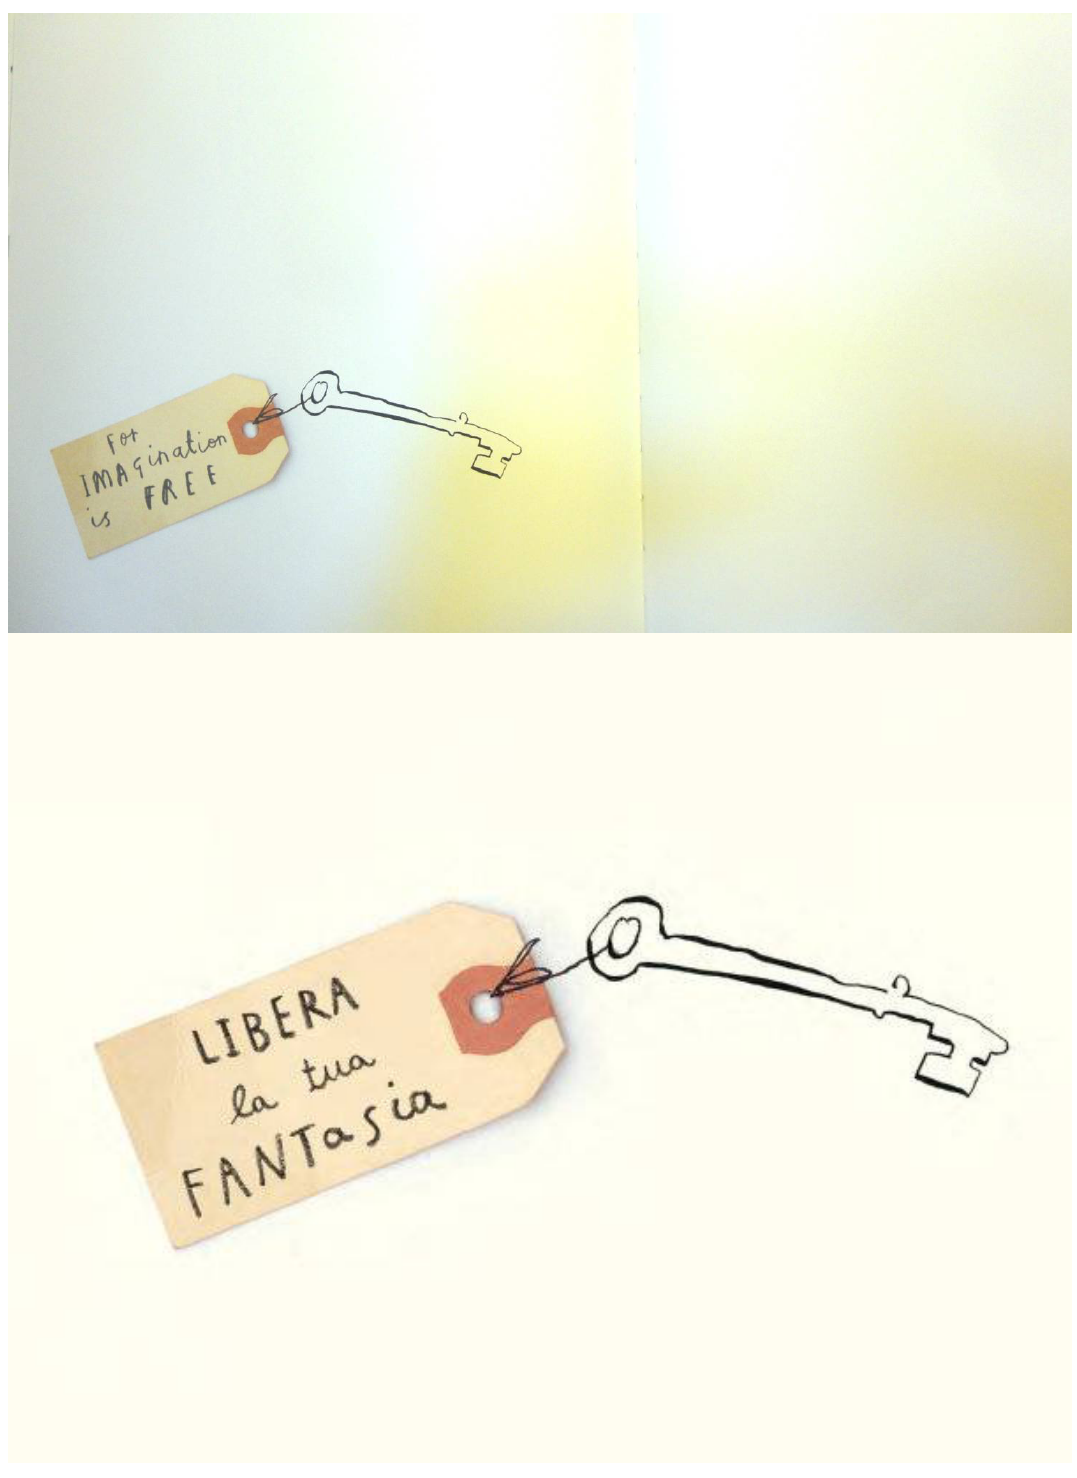
Figure A22. Jeffers O.; Winston S. A child of books, Walker Books, London, 2016; Jeffers O.; Winston S. La bambina dei libri, Lapis, Roma,